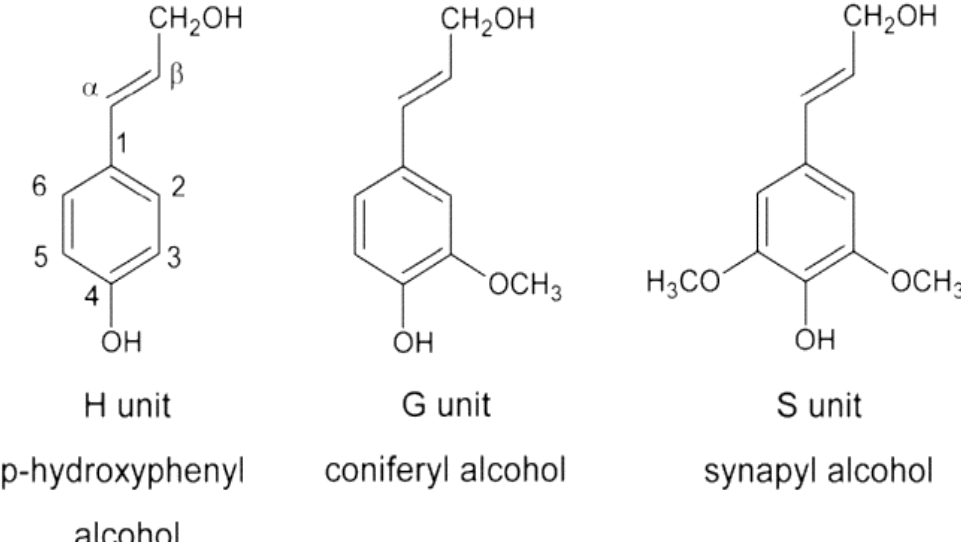
Figure 2. Representative hemicellulose structure (Reprinted with permission from [45]. Copyright 2014, Elsevier).